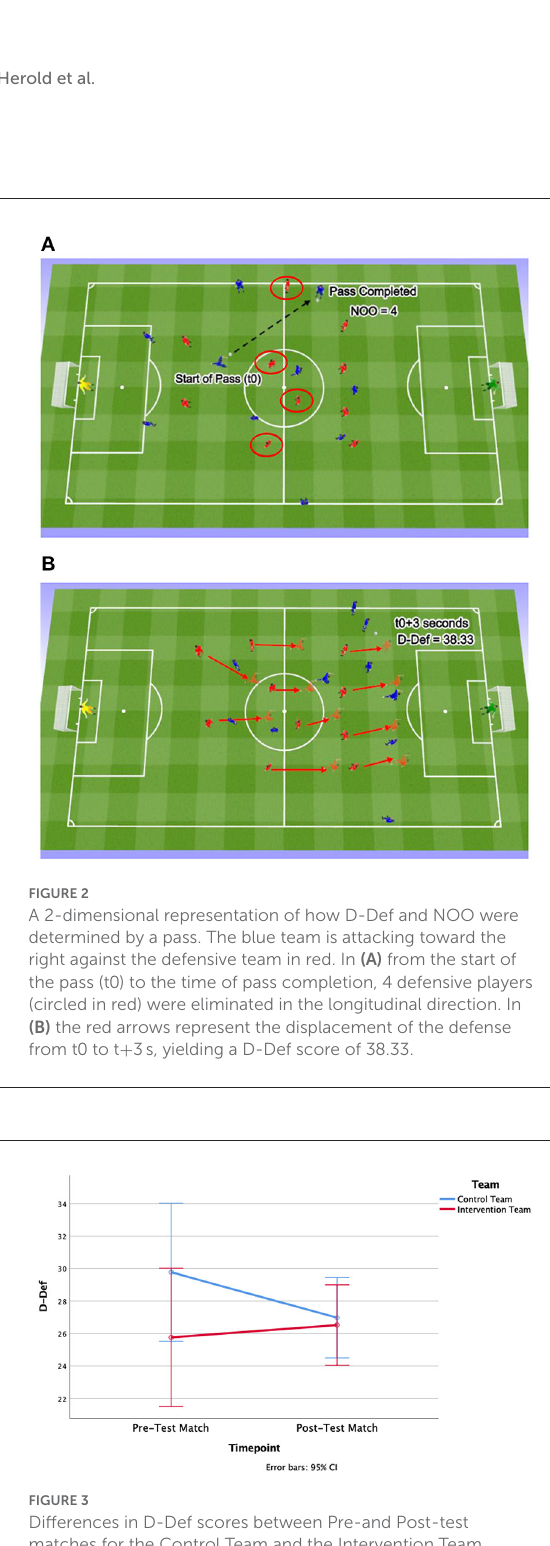
pass was given (t0) and 3s later (t0 + 3). D-Def is constructed by three components: the disruption in the longitudinal and lateral directions, and disruption of the team surface and spread area [For an in-depth description, see (33)]. This results in a measure from 0 to 150 (with 0 indicating no disruption and 150 indicating a maximum of disruption).